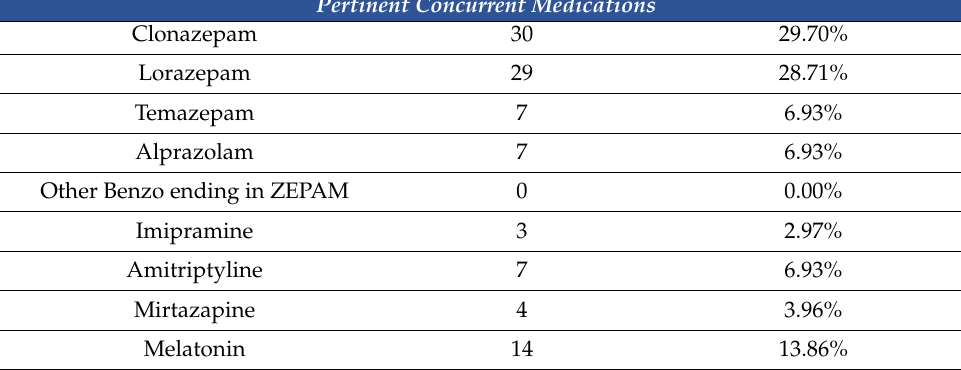
Figure 1. Proportions of comrbidites of patients with NREM parasonmia. Table 1. Frequencies and proportions of pertinent concurrent medications.